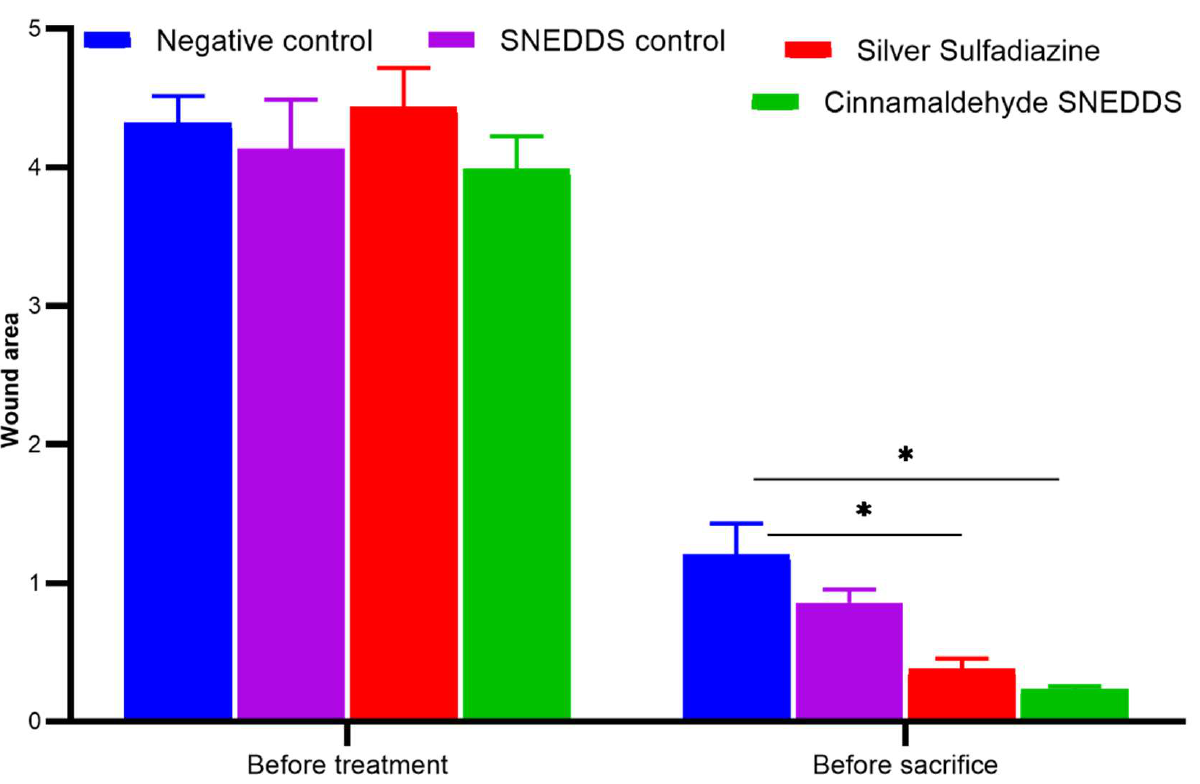
Figure 5. Wound size on day 0 of skin burn induction and after 3 weeks of treatment. Values are denoted as mean ± SEM, N = 5 rats per group. Statistical significance was found using two-way ANOVA, followed by a post hoc test in GraphPad Prism 8.0.2. * p < 0.05 using Tukey’s multi-group comparisons.